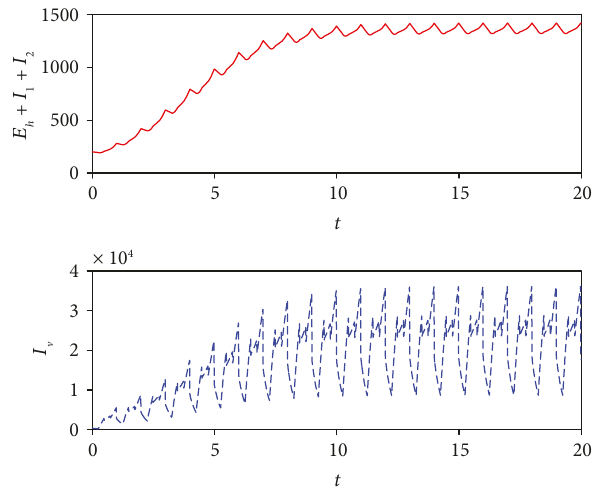
Figure 3: Time series plots of the total of infected trees and infected psyllids. The disease is persistent with R Table 2: The e ff ect of parameters p